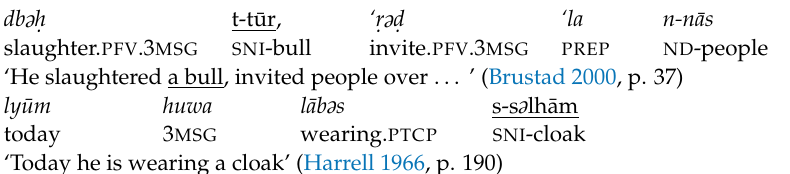
Figure 3. Reference Hierarchy for Libyan.